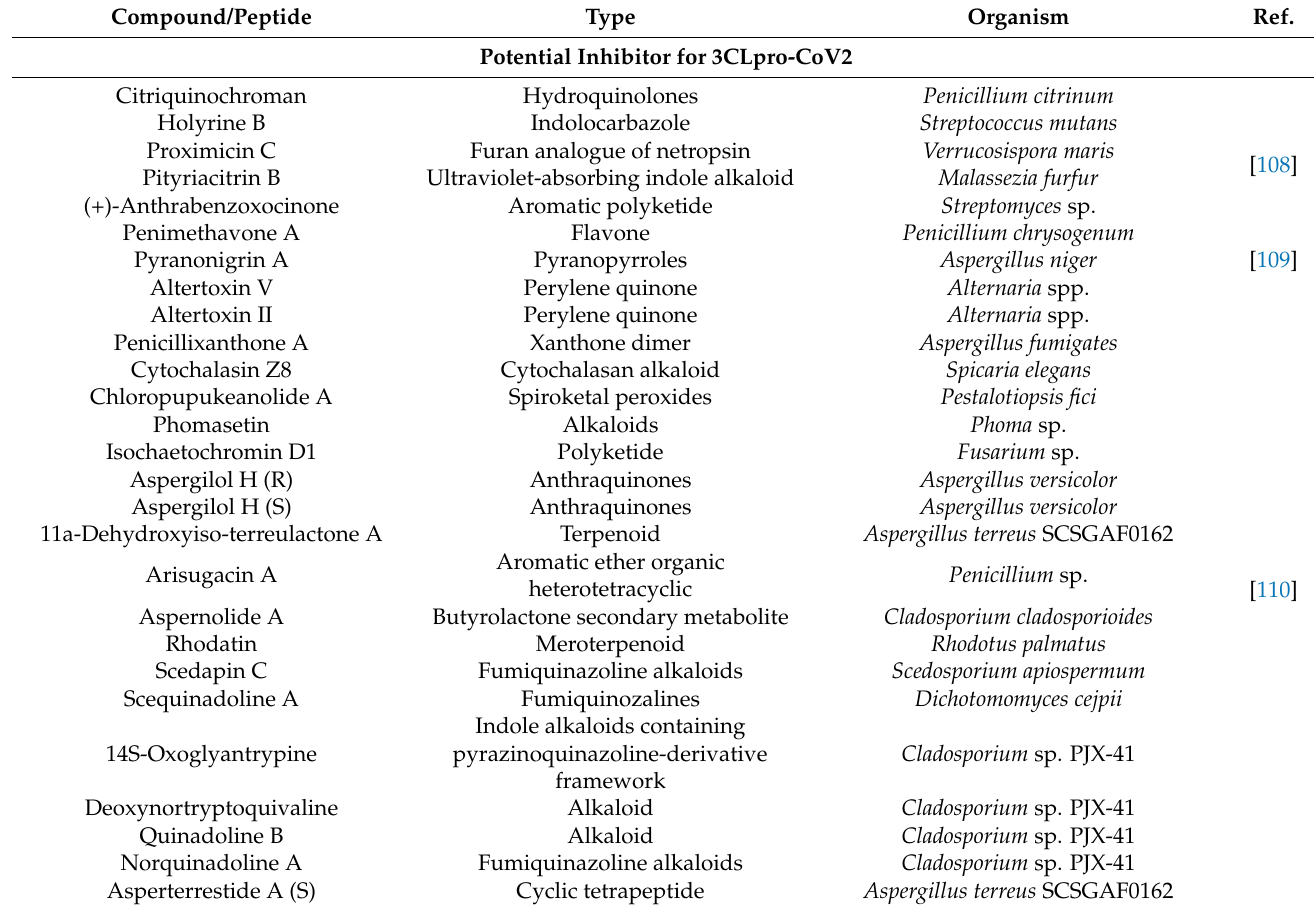
Table 1. List of the potential inhibitors from microbial sources for SARS-CoV-2 proteases.